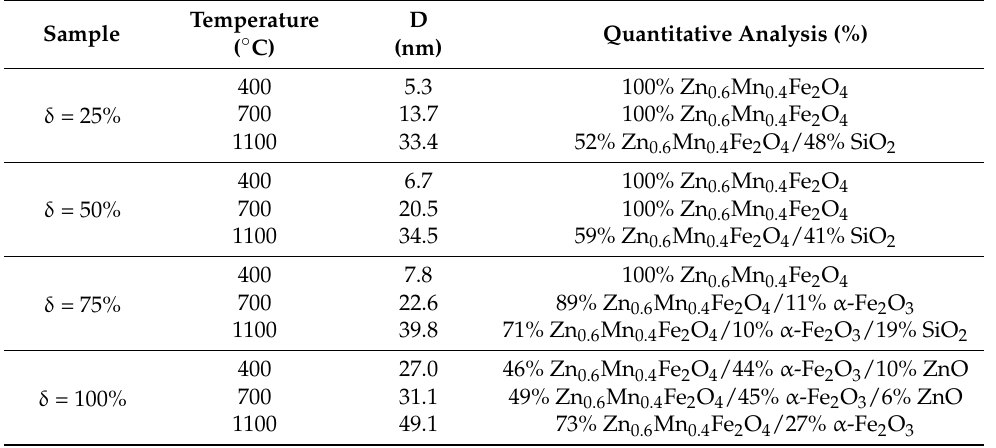
Table 1. The crystallite size and quantitative analysis according to XRD of (Mn 0.6 Mn 0.4 Fe 2 O 4 )